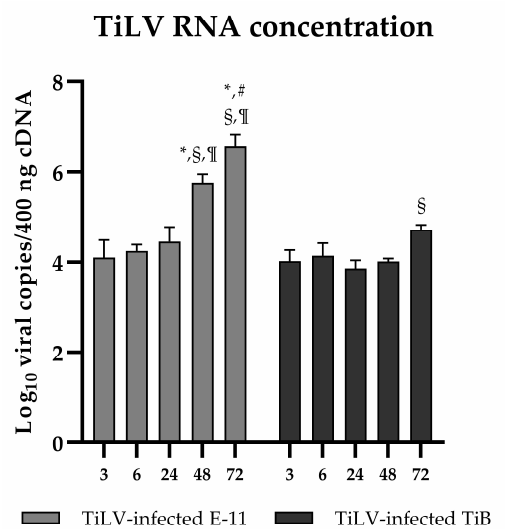
Figure 2. The number of TiLV RNA copies in the E-11 and TiB cells was determined following TiLV infection (n = 3 each) and is presented as the mean ± SEM. The statistical analysis revealed significant differences at various time points, as indicated by the following: * p < 0.05 compared to 3 hpi, # p < 0.05 compared to 6 hpi, § p < 0.05 compared to 24 hpi and ¶ p < 0.05 compared to 48 hpi.